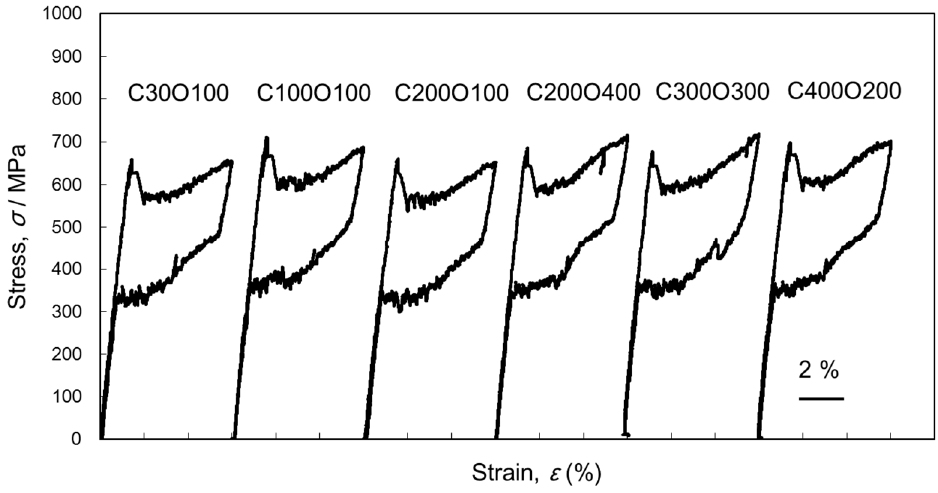
Figure 5. Stress-strain curves of Ti-Ni wires at 37 °C. Table 2. Young’s modulus of Ti-Ni wires.